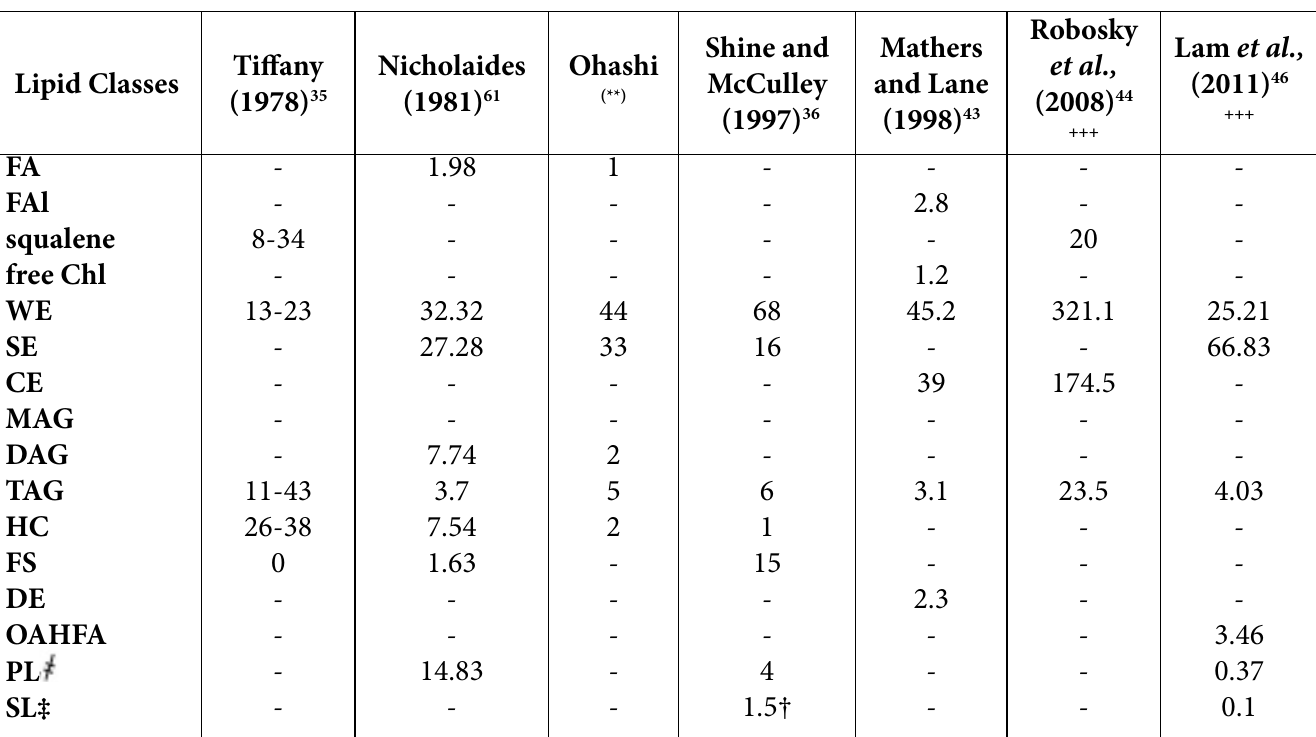
Table 1. Lipid composition of human meibum according to previous studies. CE, cholesteryl esters; DAG, diacylglycerols; DE, diesters; FA, free fatty acids; FAl free fatty acids alcohols; free Chl, cholesterol; FS, free sterols; HC, hydrocarbons; MAG, monoacylglycerols; SE, sterol esters; TAG, triacylglycerols; WE, wax esters. ҂PL, phospholipids refers to sum total of PC, phophatidylcholine; PE, phosphatidylethanolamine; PI, phosphatidylinositol; PG, phosphatidylglycerol. ‡SL, sphingolipids refers to sum total of: SM, sphingomyelin; cerebrosides; CER, ceramides; GluCer, glucosylceramide; dihexcer, dihexosylceramide. † Only ceramides was measured. ( ** ) Not an original study; ( +++ ) Looked at main components of meibum. Numbers are mass percentages of all the compounds investigated in meibum; (-) Not